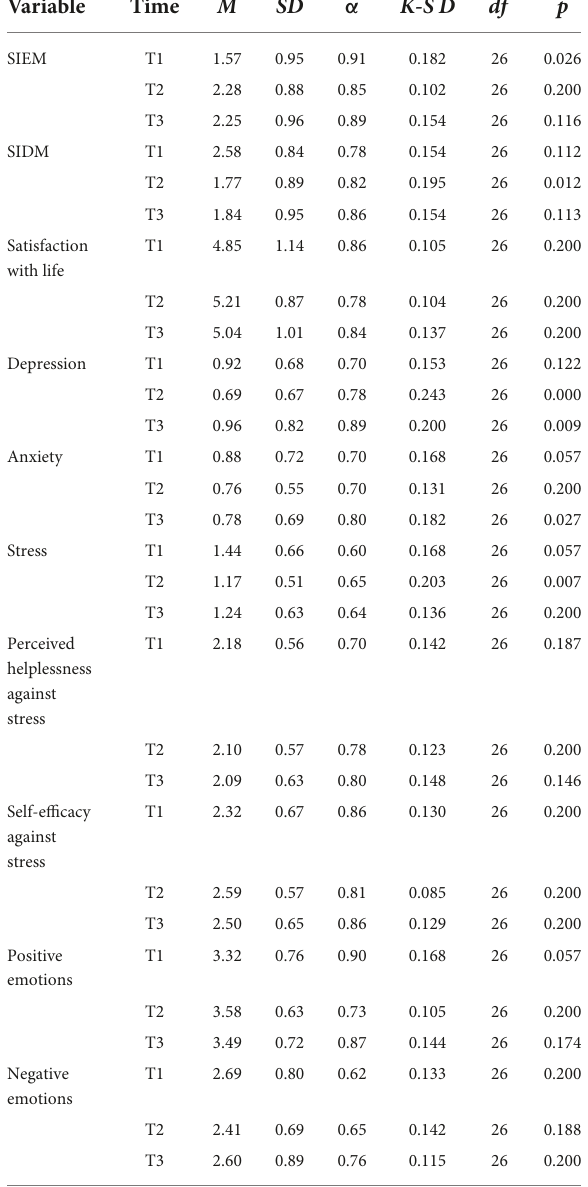
TABLE 2 Descriptive statistics, alpha levels, and normality coefficients of study variables for the three time-points ( N =